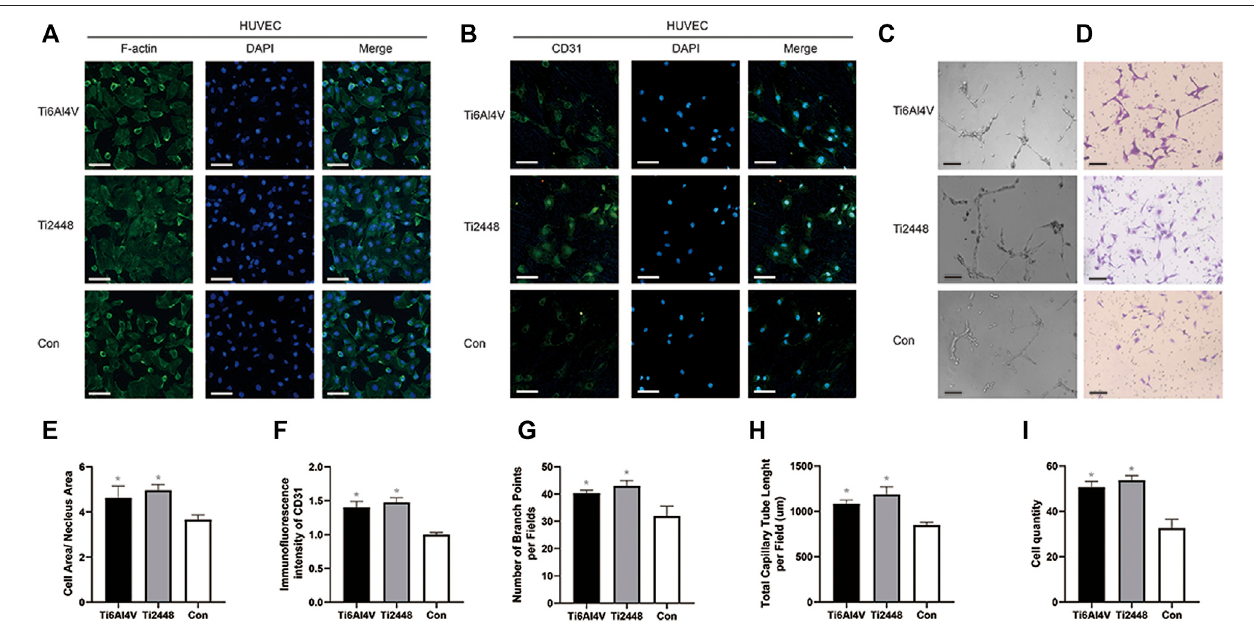
FIGURE7| EvaluationoftheeffectsofthedifferentscaffoldsonangiogenesisinHUVECs invitro .Immuno fl uorescencestainingforexaminationofthecytoskeleton and expression of the angiogenic marker CD31 in HUVECs. Scale bar (cid:2) 100 µm (A,B) . Tube formation (C) and Transwell (D) assays to determine the effect of different scaffolds on HUVECs. Scale bar (cid:2) 200 µm. Quantitative analysis ofthe cell area/nuclear area in different groups (E) . Quantitative analysis of the fl uorescence intensity of CD31 in different groups (F) . Quantitative analysis of the number of branch points per fi eld in different groups (G) . Quantitative analysis of the total capillary tube length per fi eld in different groups (H) . Quantitative analysis of the cell quantity in different groups (I) . Note: * p ＜ 0.05 compared to the control.